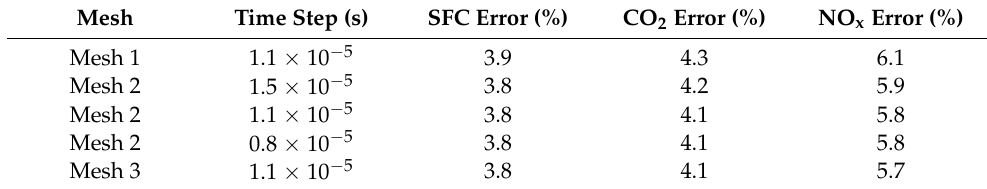
Table 1. Mesh size and time-step sensitivity analysis.